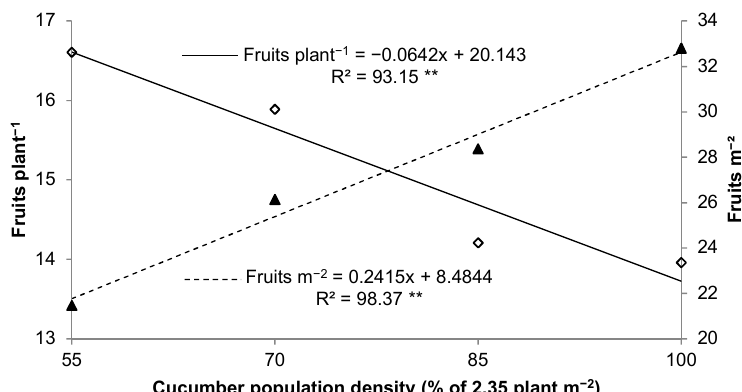
Figure 5. Number of fruits per plant and area of cucumber as a function of population densities. ♦ Fruits plant −1 ; ▲ Fruits m −2 . ** p ≤ 0.01 in F test.